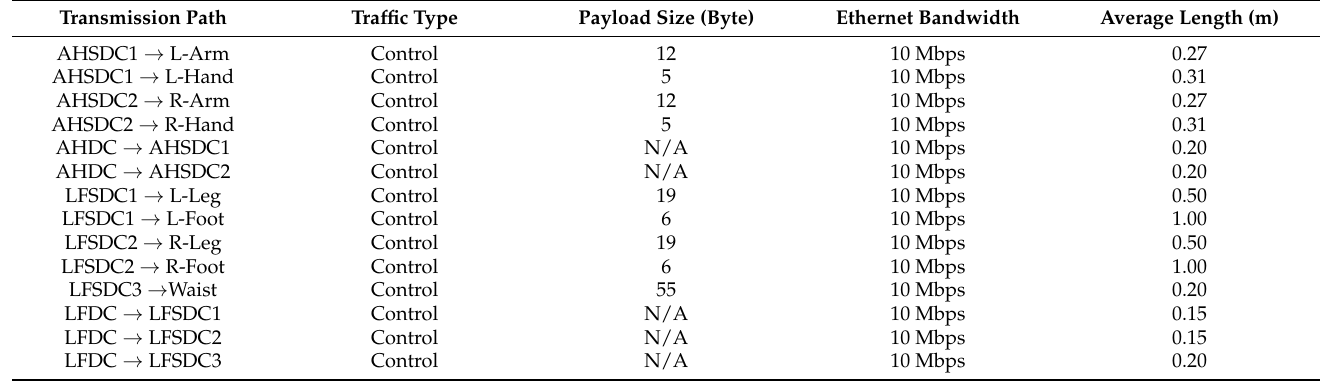
Table 3. Data transmission link parameters of the DIRA Arm and Hand Domain, Leg and Foot Domain.